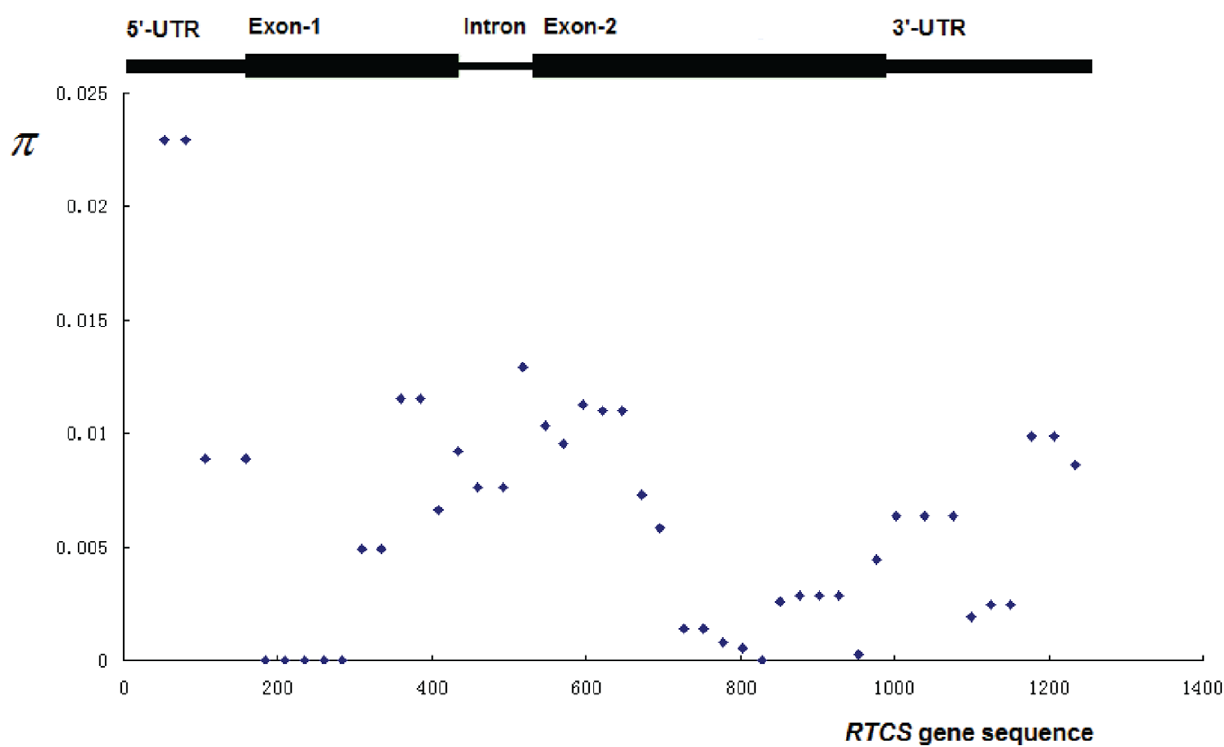
Figure 1. The nucleotide diversity ( p ) estimated along the RTCS gene sequences. p is calculated in sliding windows of 100 bp using a step size of 25 bp. 5 regions of RTCS gene, including 5 9 UTR, Exon-1, Intron, Exon-2, and 3 9 UTR, were indexed on the top of the coordinate.